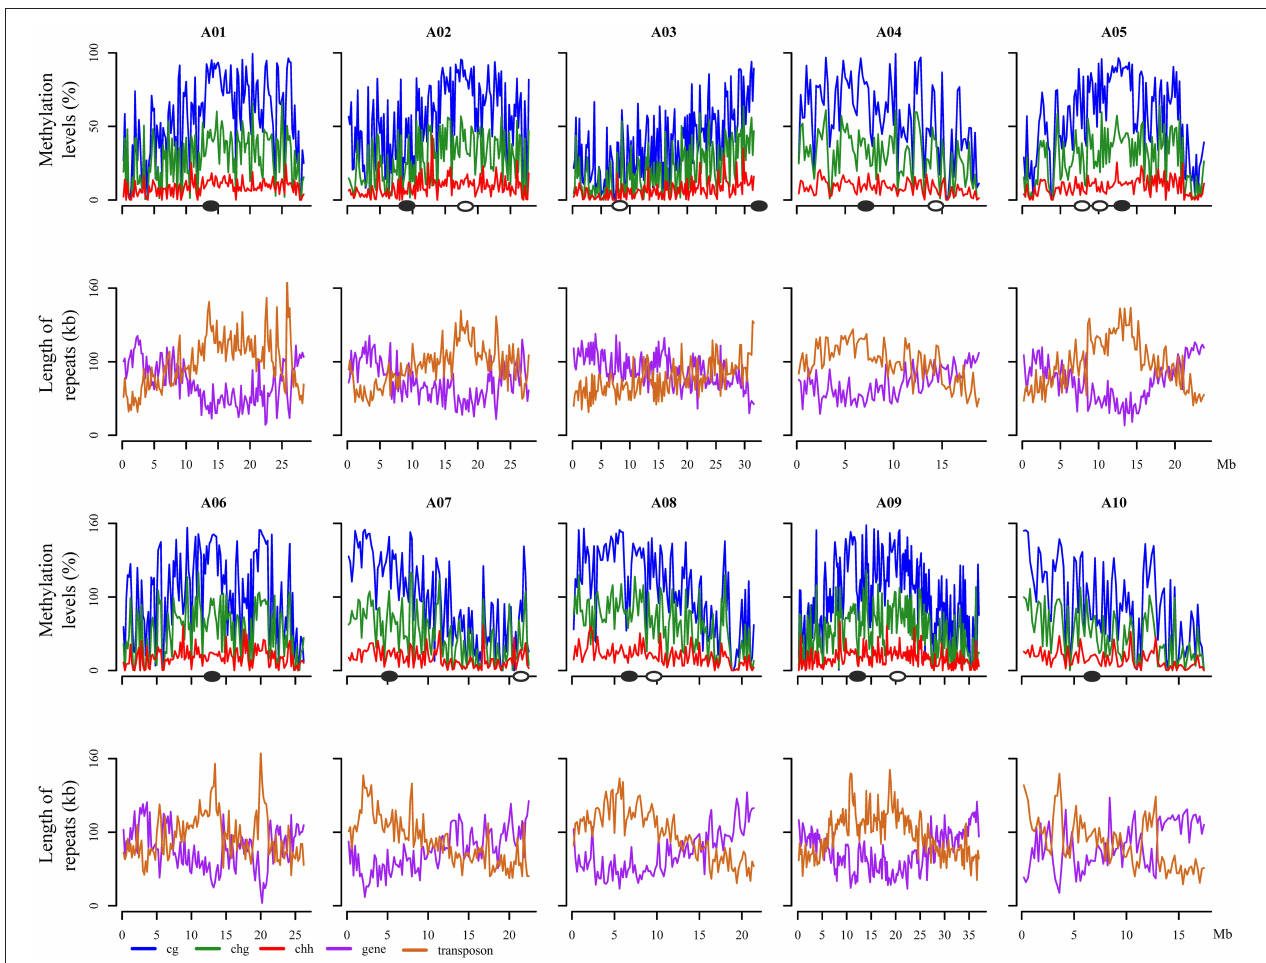
FIGURE 1 | Genome-wide distribution of methylation level, transposon and gene contents along 10 B. rapa chromosomes. The X axis indicates the physical distances, and Y axis indicates the average methylation level or length of repeat in each 200-kb windows. Solid oval circles stand for the position of real centromeres, blank oval circles stand for the position of ancient centromeres (Wang et al., 2011; Cheng et al., 2013). CG, CHG, and CHH (where H = A, T, or C) indicates methylated cytosine residues in different sequence